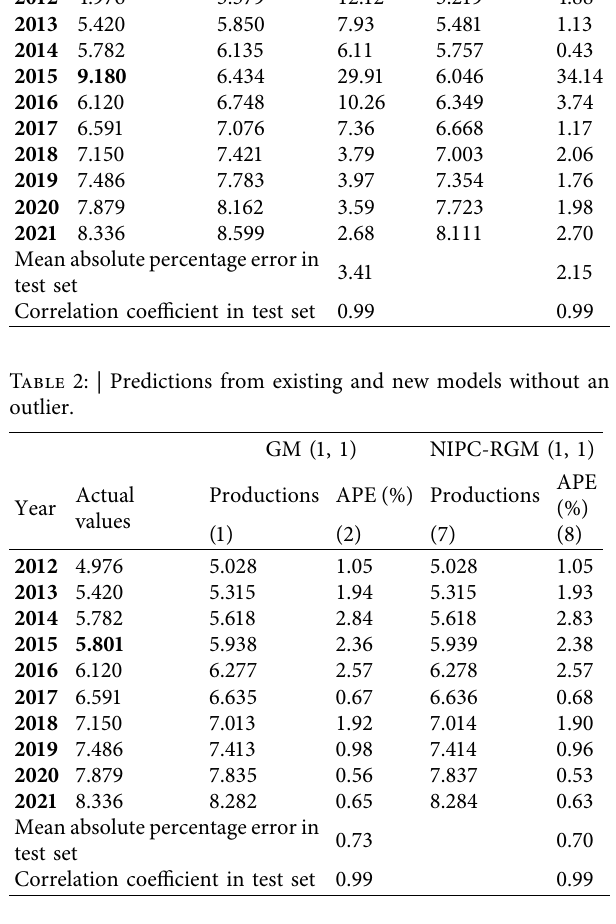
Table 1: | Predictions from existing and new models with an outlier. Year Actual values